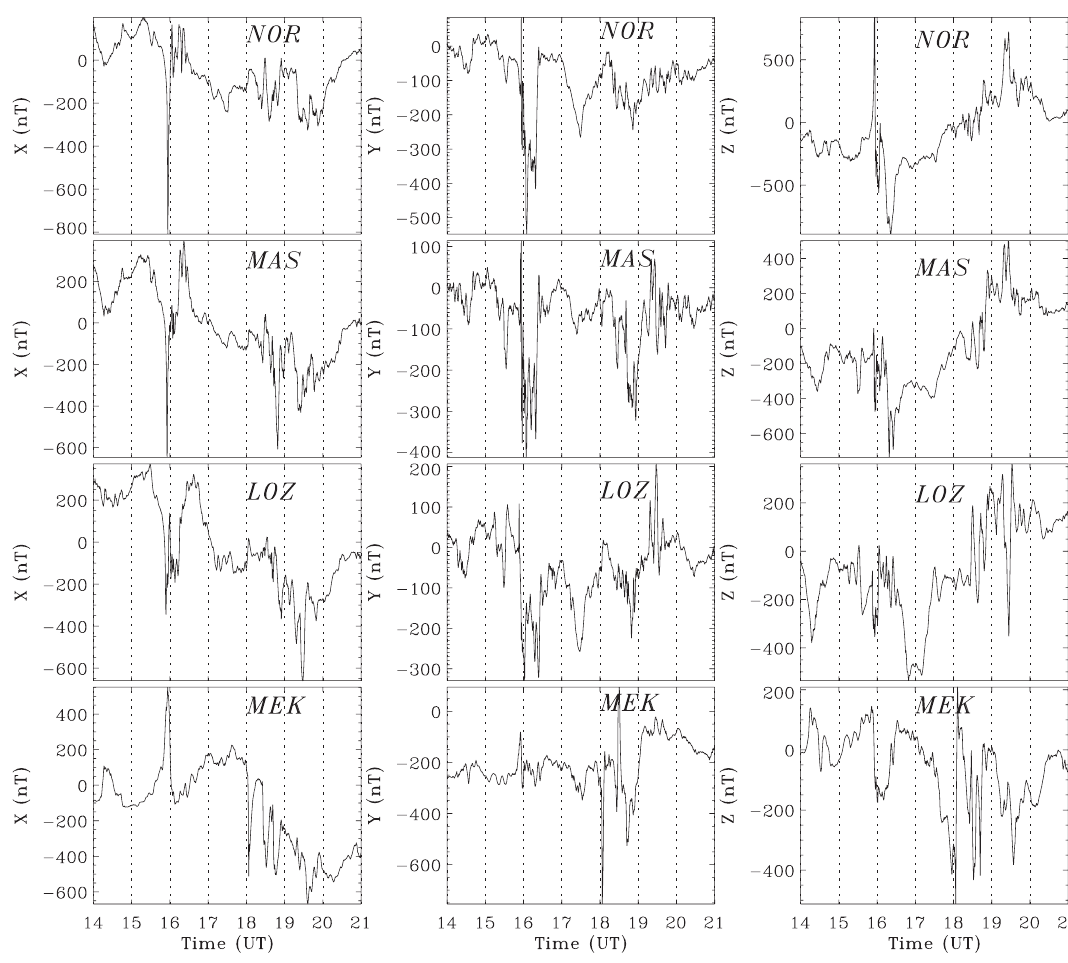
Fig. 5. Geomagnetic fi eld variations at the latitudinal array of stations NOR, MAS, LOZ, and MEK (10-s data) from the IMAGE array during the magnetic storm on March 17, 2013: X -, Y -, and Z -components.